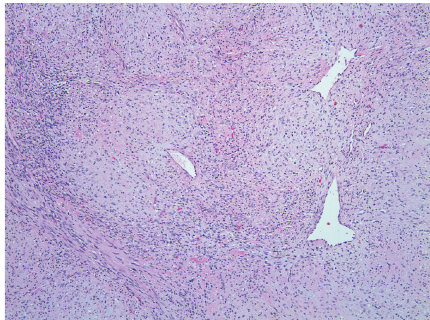
Figure 5: Tumor cells show shows strong reactivity for mus- cle specific actin (HHF35) (immunohistochemical stained-section, original magnification ×